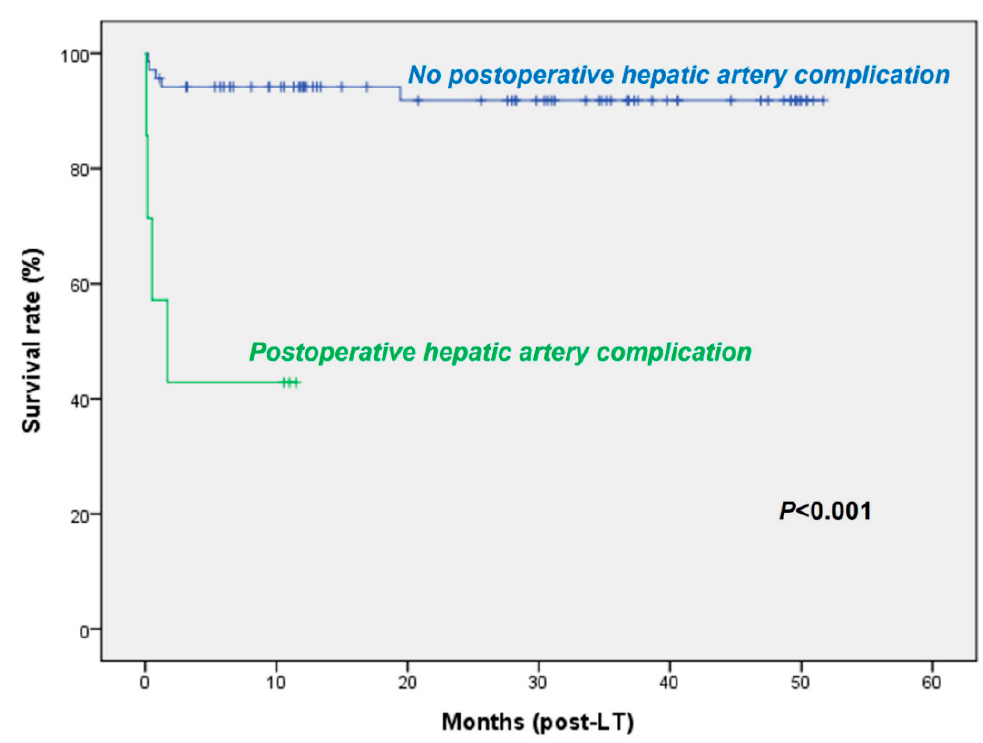
Figure 5. Kaplan–Meier analysis of overall survival using the KOTRY database according to postoperative hepatic artery complication.